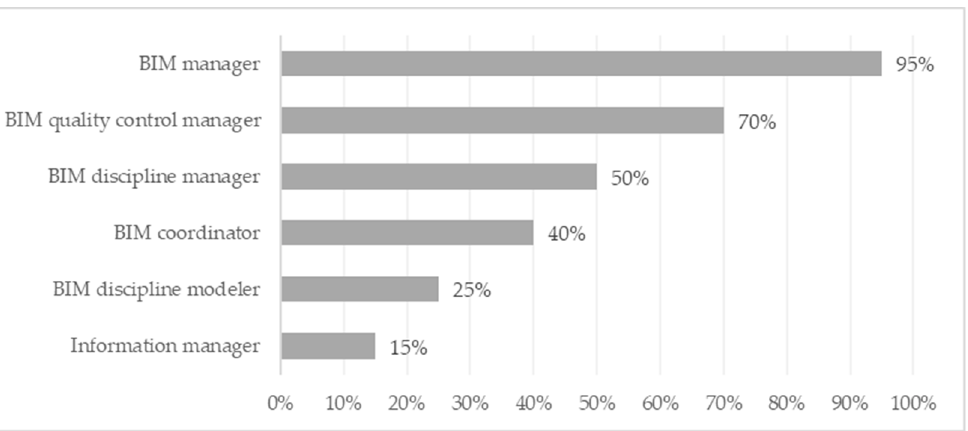
Figure 11. BIM roles identified in the analyzed contracts.